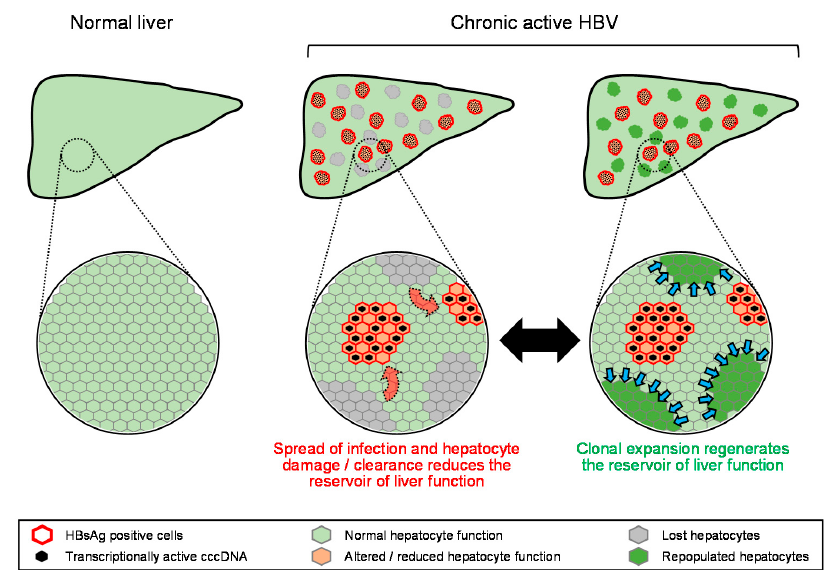
Figure 3. Model for the equilibrium between loss and regeneration of the hepatic reservoir during chronic HBV infection. Red arrows indicate expansion of HBV infection, blue arrows indicate regeneration of normal hepatocytes.